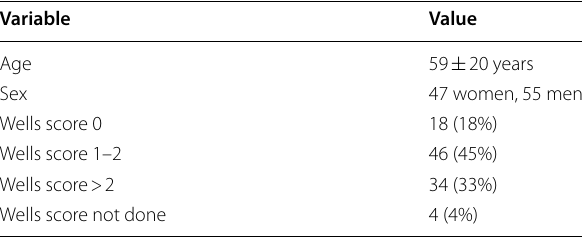
Table 1 Main characteristics and Wells score of the 102